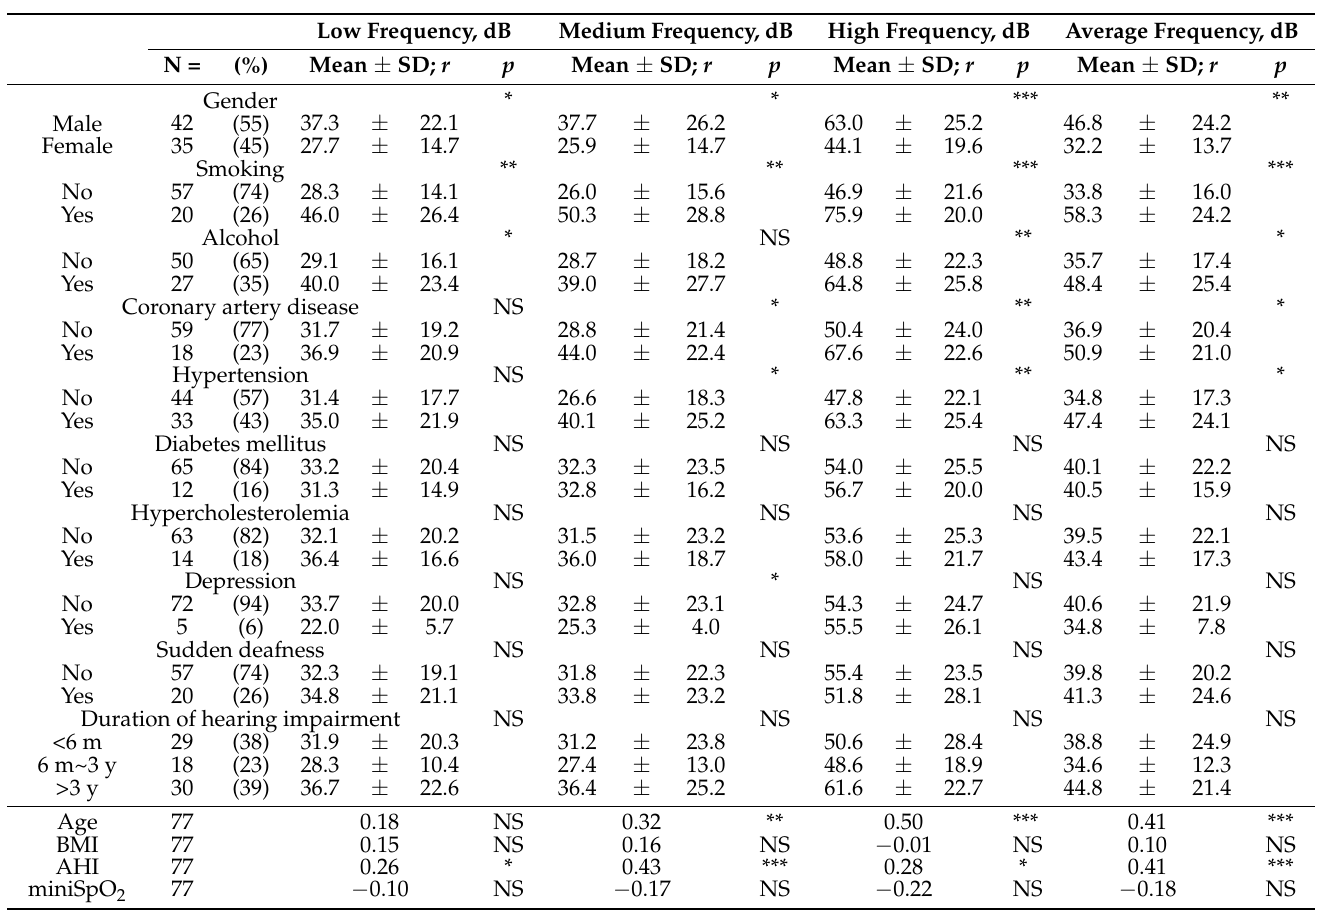
Table 2. The relationship between baseline measures of hearing thresholds at various frequencies and anthropometric variables, comorbid diseases, hearing-specific history, and severities of hearing impairment and sleep-disordered breathing by univariate analysis.